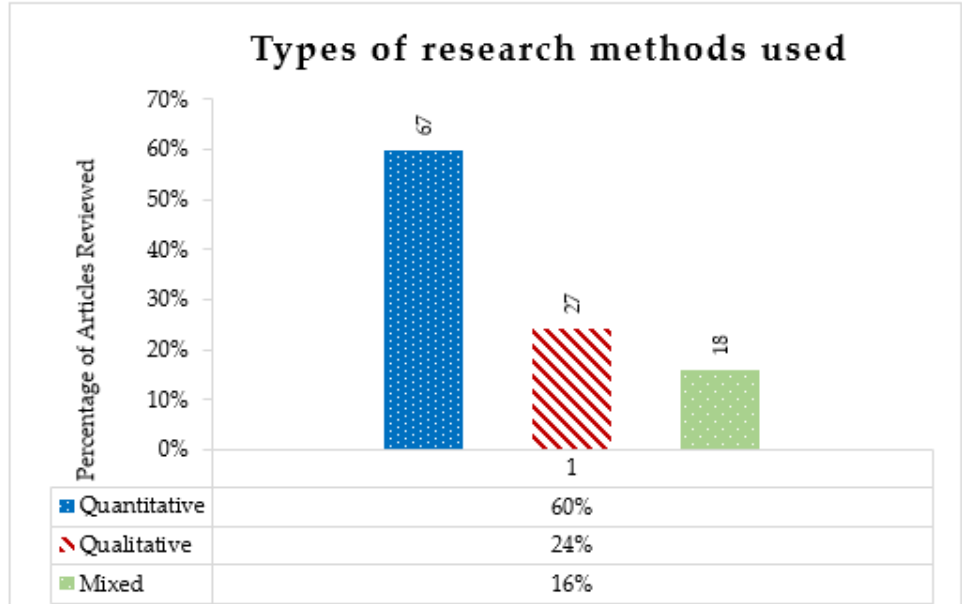
Figure 6. Types of research methods used.